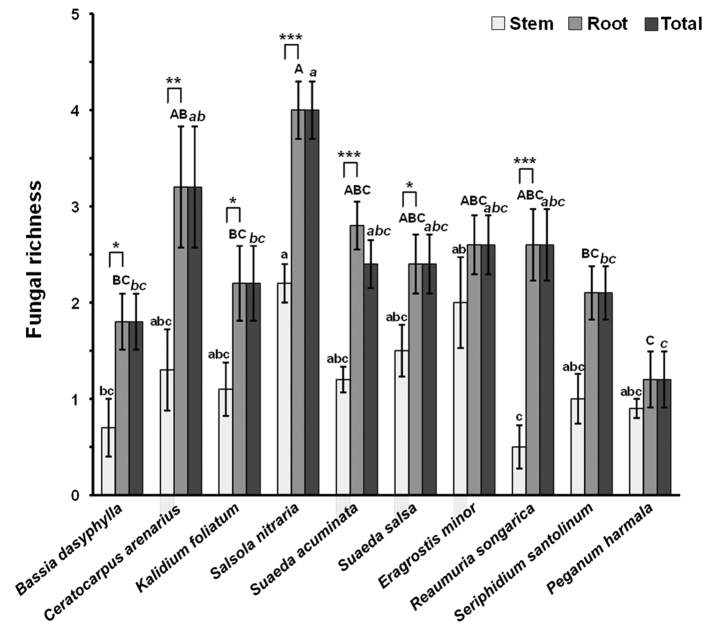
Endophytic fungal richness in stem, root and total (stem + root) tissues of the ten halophyte species. Data are means ± SE (n = 10). Columns without shared lowercase, uppercase, and italic letters denote significant difference in the stem, root, and total tissues among the plant species, respectively. Asterisks above bars indicate the significant difference between stem and root tissues for each halophyte species (* P<0.05, ** P < 0.01, *** P < 0.001).